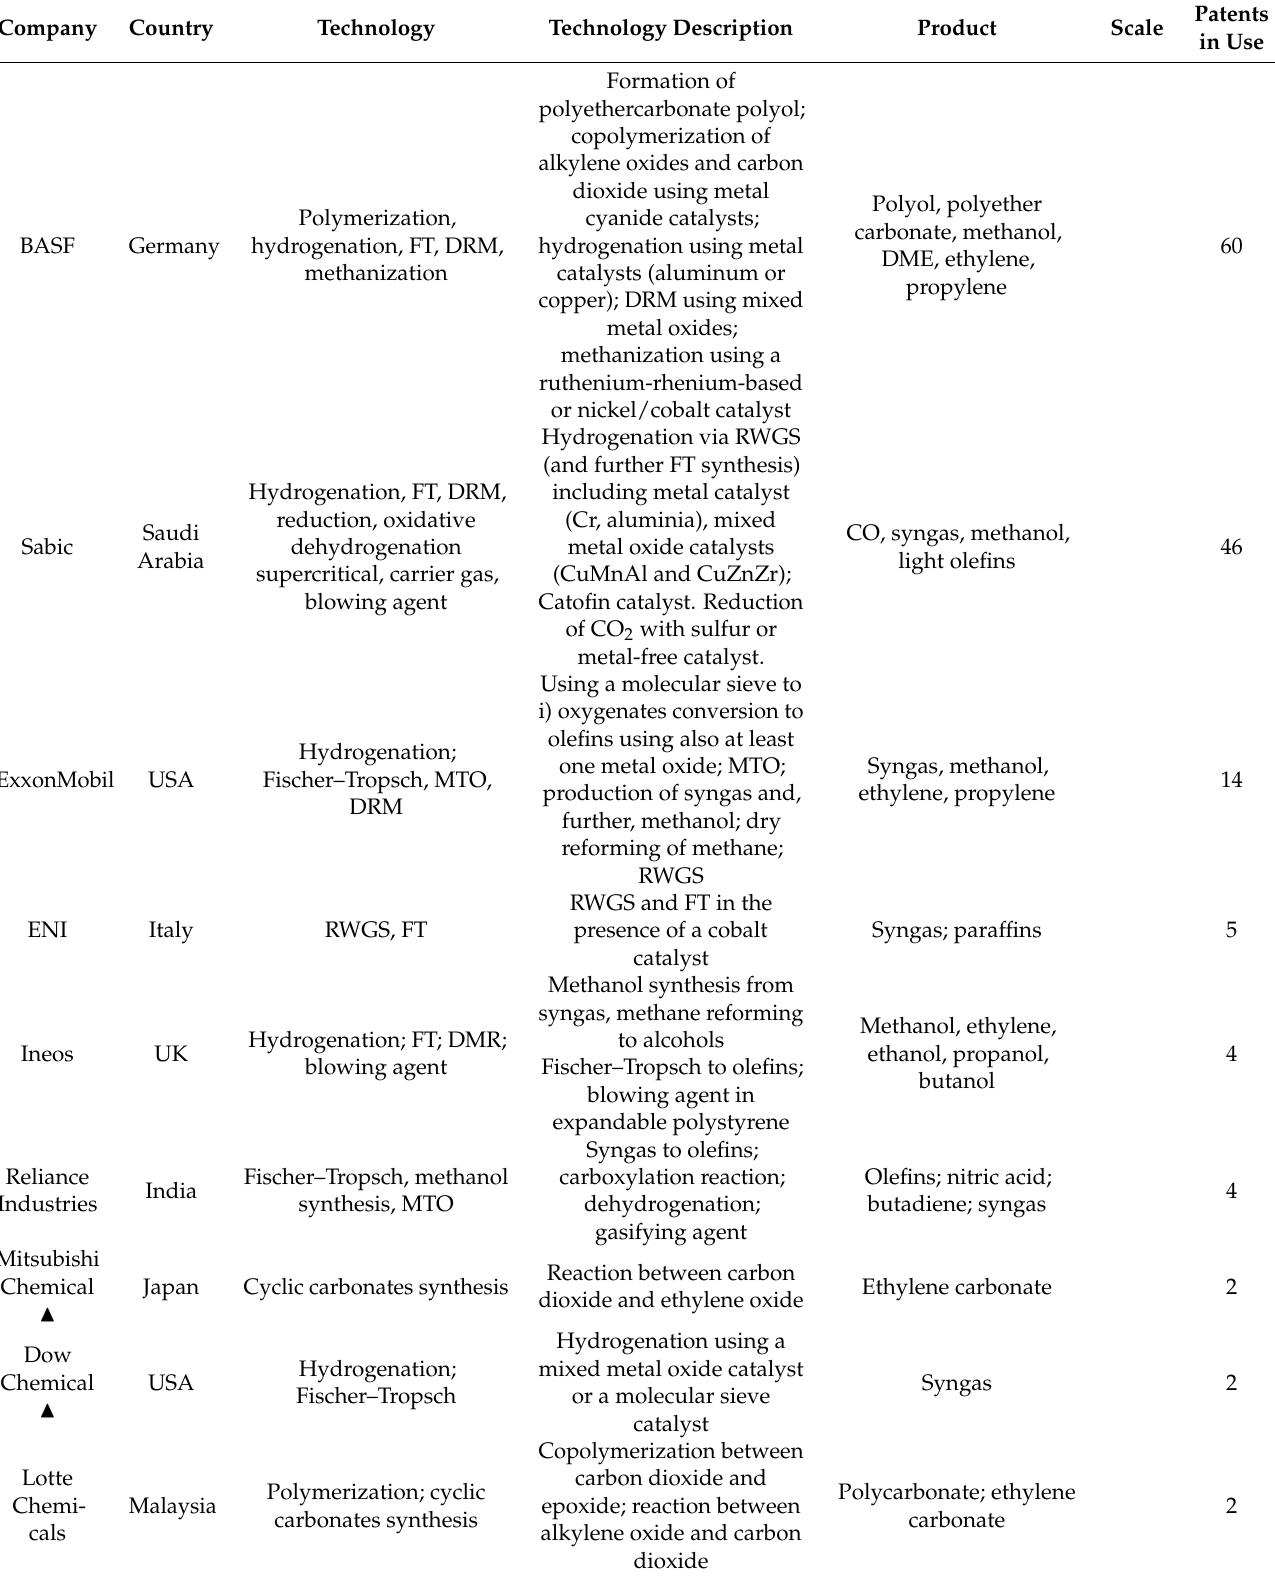
Table 28. Technology description of CO 2 utilization solutions developed by chemical and plastic producers.